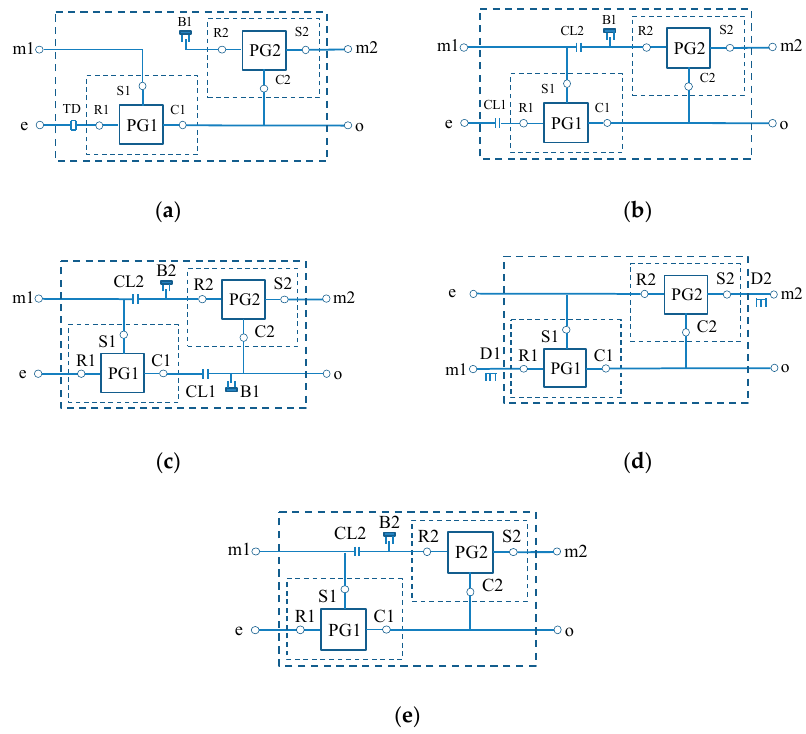
Figure 21. Port diagram of five architectures: ( a ) THS with dual-PG; ( b ) GM AHS; ( c ) Timken EVT; ( d ) Renault IVT; ( e ) Voltec II.